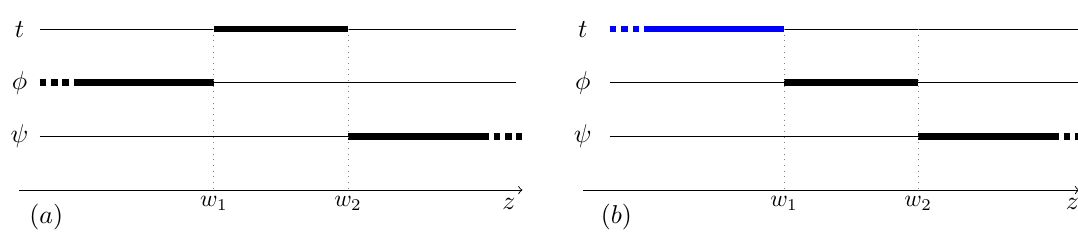
Figure 4 . ( a ) : rod diagram for the 5D Schwarzschild-Tangherlini black hole. The finite timelike rod defines the black hole horizon (a sphere S 3 , fibering φ and ψ circles over w 1 < z < w 2 ). Exchanging t φ gives ( b ) : rod diagram of the five-dimensional expanding bubble of nothing. The timelike ↔ semi-infinite rod represents the bubble acceleration horizon (which is connected, with topology R 2 : the ψ circles are trivially fibered over S 1 ×